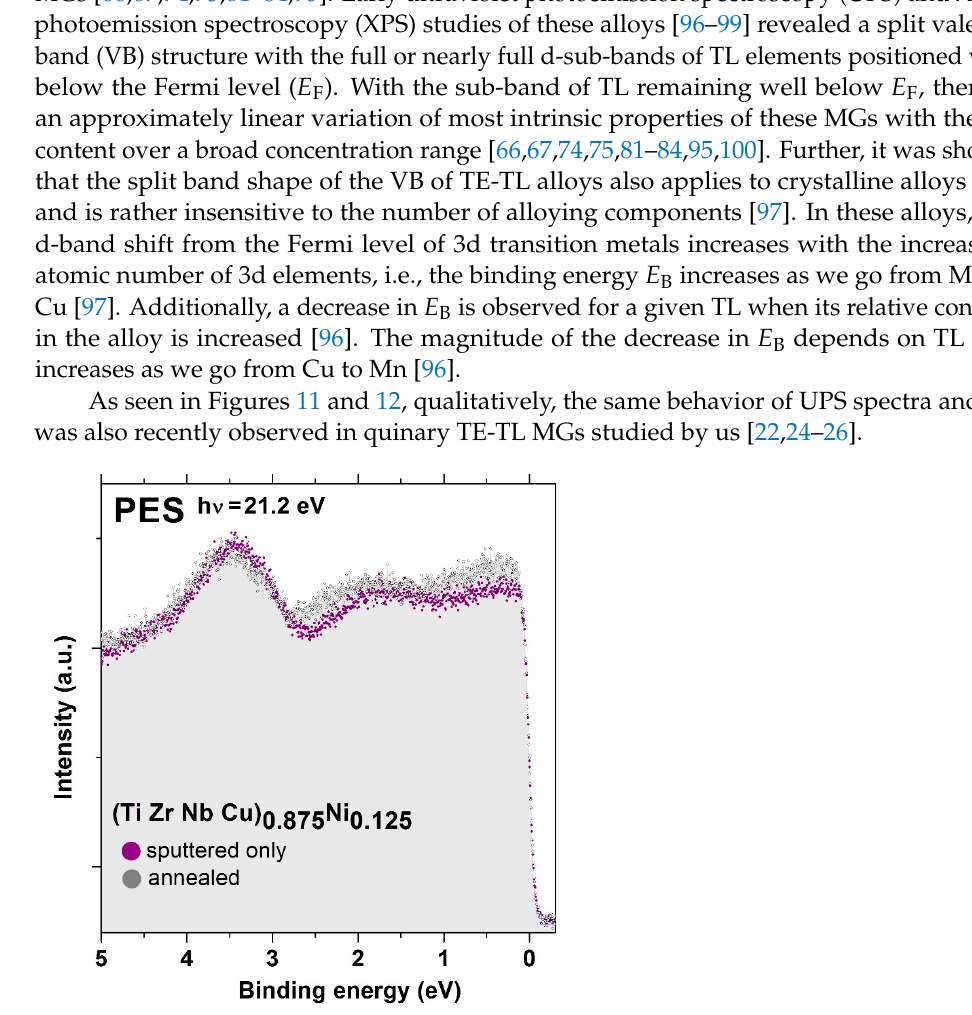
Figure 11. Ultraviolet photoemission spectra of as-cast (denoted sputtered only) and annealed (TiZrNbCu) 0.875 Ni 0.125 samples. The annealing conditions correspond to those of the uppermost XRD pattern in Figure 9.